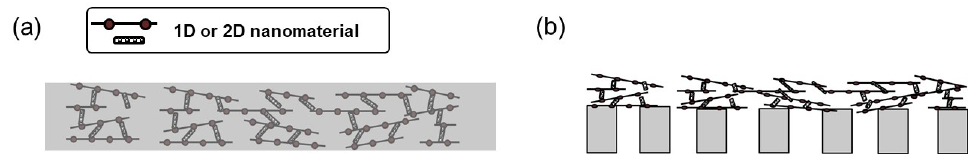
Figure 3. Schematic diagram illustrating the two most commonly adopted membrane structures for incorporating 1D and 2D nanomaterials in electrically responsive membranes. ( a ) polymeric matrix incorporated with nanomaterials, and ( b ) nanomaterial-deposited on porous substrate.